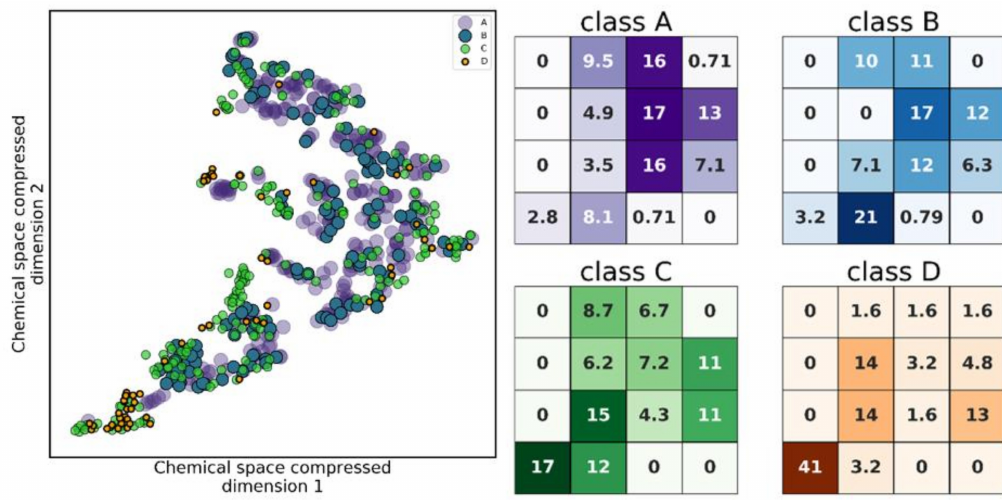
Figure 4. (Left) Chemical space of the four half maximal inhibitory concentration (IC 50 ) value classes, where an uneven distribution of classes can be seen. (Right) Density of data points per class, represented as % points from a given class found in a specific region of the plot, with respect to the total amount of points from that class. Class A preferentially populates the top-right quadrant of the plot, while C and D populate the lower-left